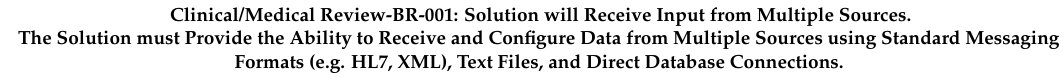
Table 1. Business and Functional Requirements for